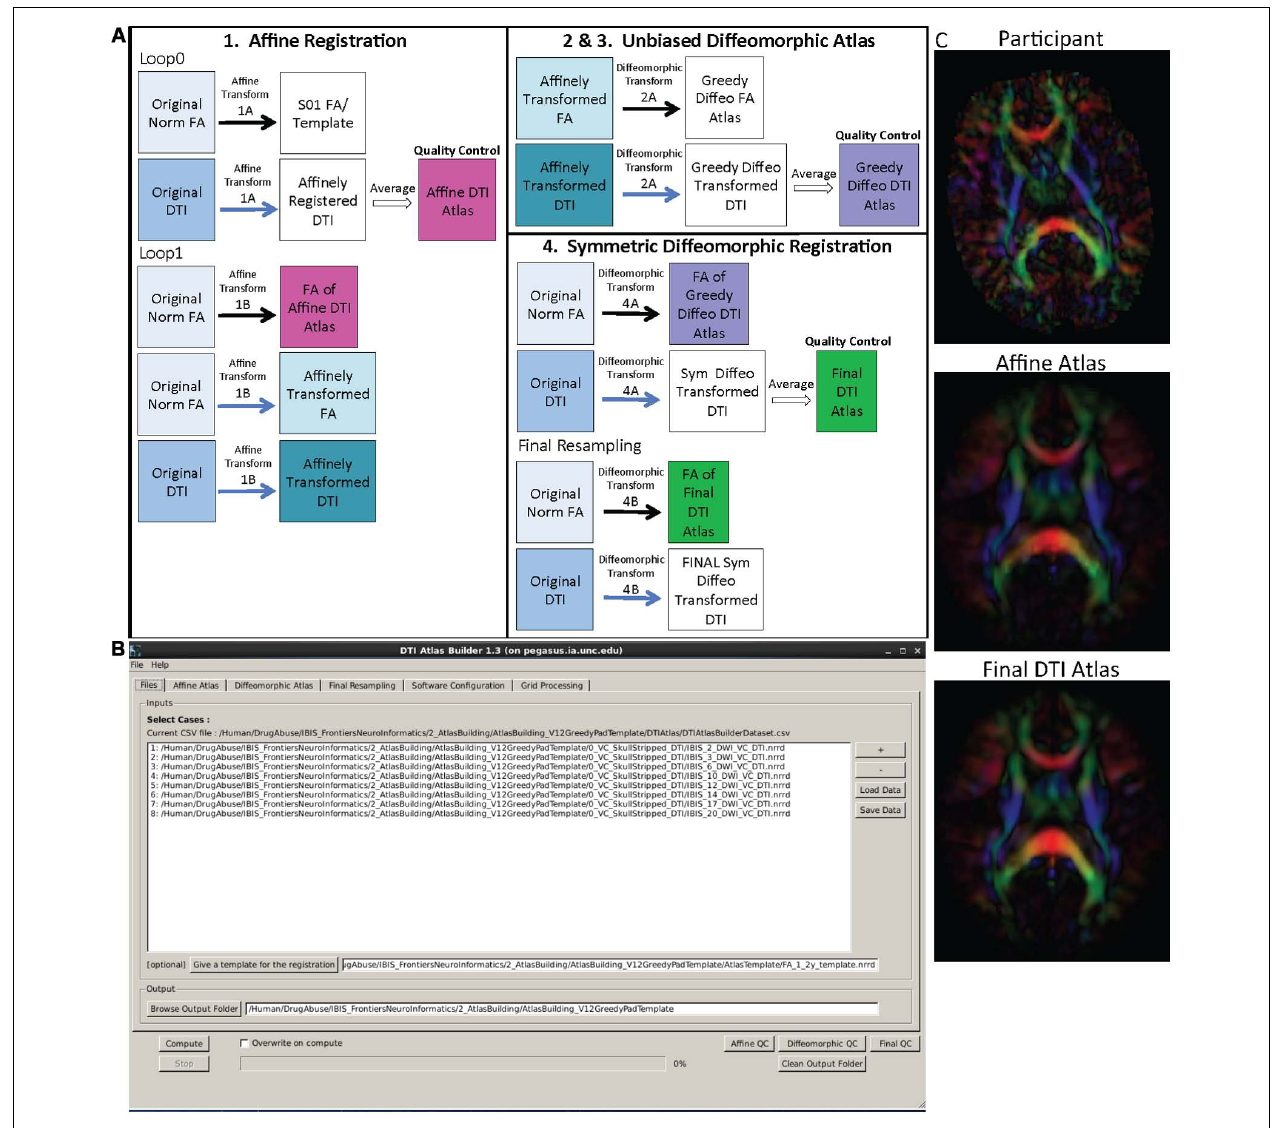
the Final (or Global) Displacement Field. It is this transform that is required to extract fiber tract profiles from each individual subject DTI when using DTIAtlasFiberAnalyzer later in the workflow. (B) DTIAtlasBuilder GUI. Here one can see the first tab with the input list of quality controlled and skull-stripped DTI volumes. Along the top of the GUI, the tabs for adjusting parameters and tool paths are visible. (C) Progression of the atlas building from a single participant volume to the affine atlas, and the final unbiased diffeomorphically registered DTI Atlas in the presented experimental pediatric